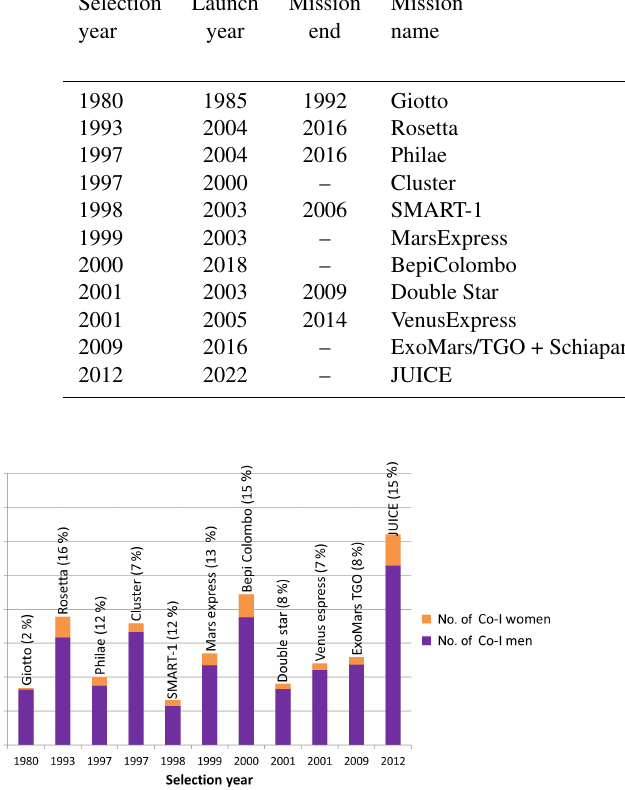
Figure 3. The percentage of women on spacecraft science teams as a function of time, after Fig. 1 in Rathbun (2017). The gray rectan- gles indicate the NASA missions. The blue circles are for ESA Co- Is and the red stars for ESA PIs.